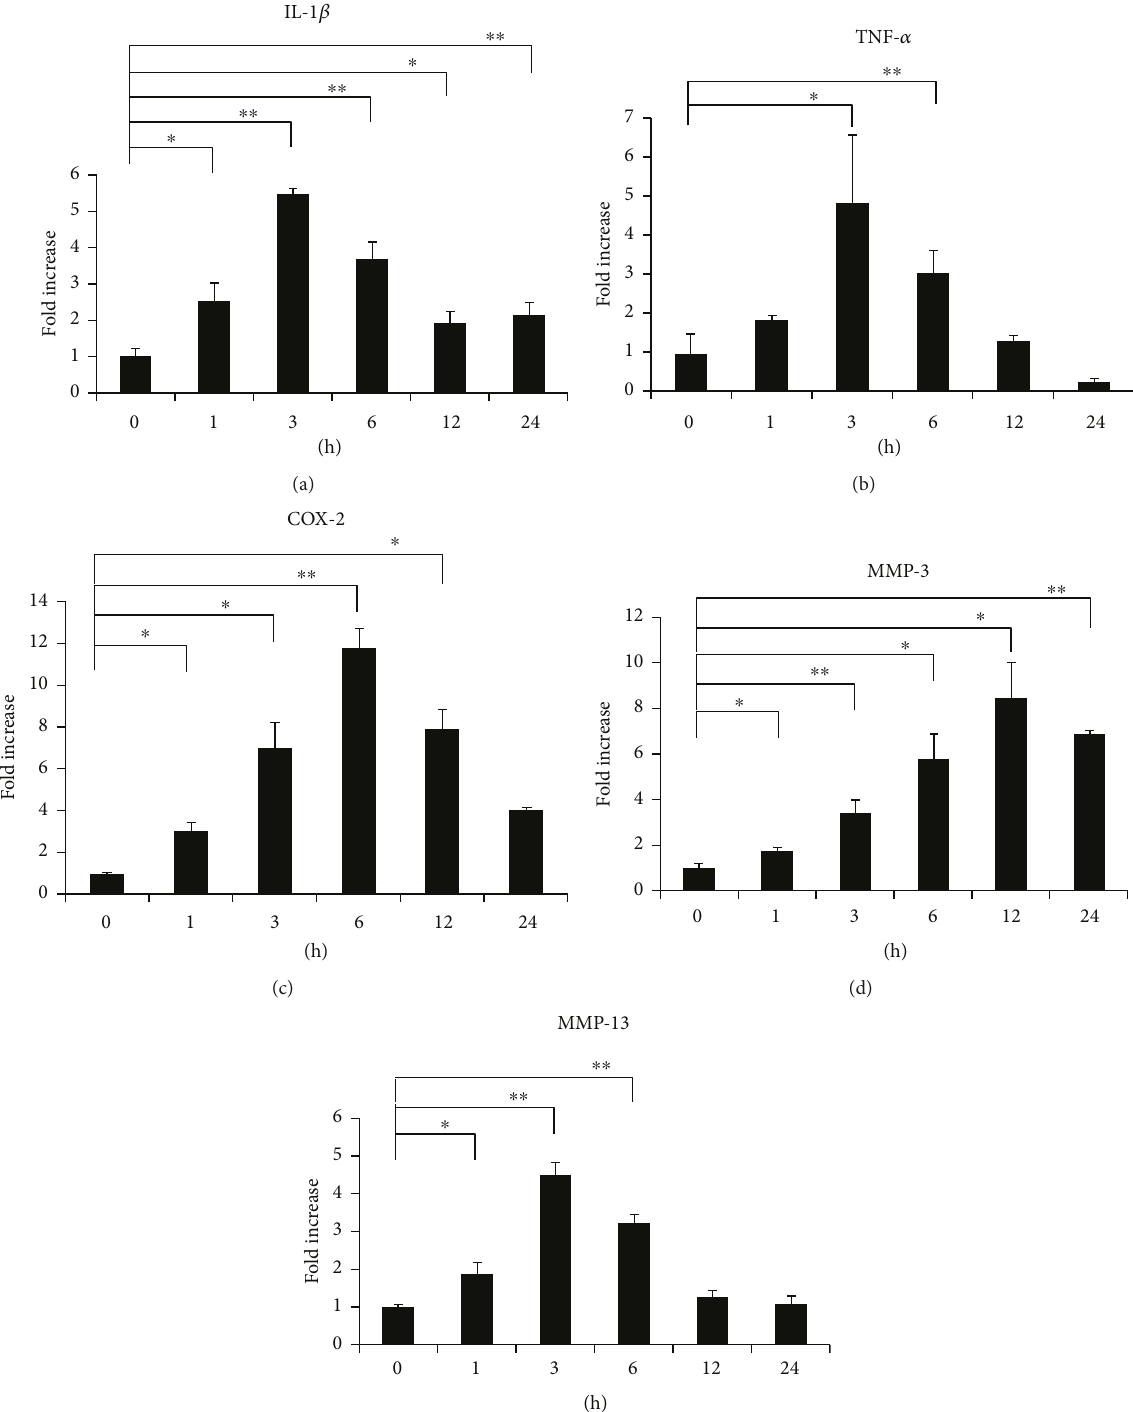
Figure 2: Change in gene expression patterns under excessive mechanical stress. ATDC5 cells were subjected to excessive CTS for 1, 3, 6, 12, or 24 h. Gene expression levels of IL-1 β , TNF- α , COX-2, MMP-3, and MMP-13 at each time point were determined by qPCR analysis (a – e). Data are expressed as mean ± SD, n = 3 . ∗ P < 0 05 , ∗∗ P < 0 01 compared to controls at each time